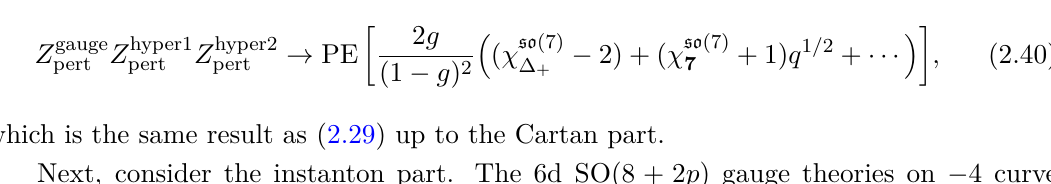
perturbative part Z gauge Z hyper1 pert